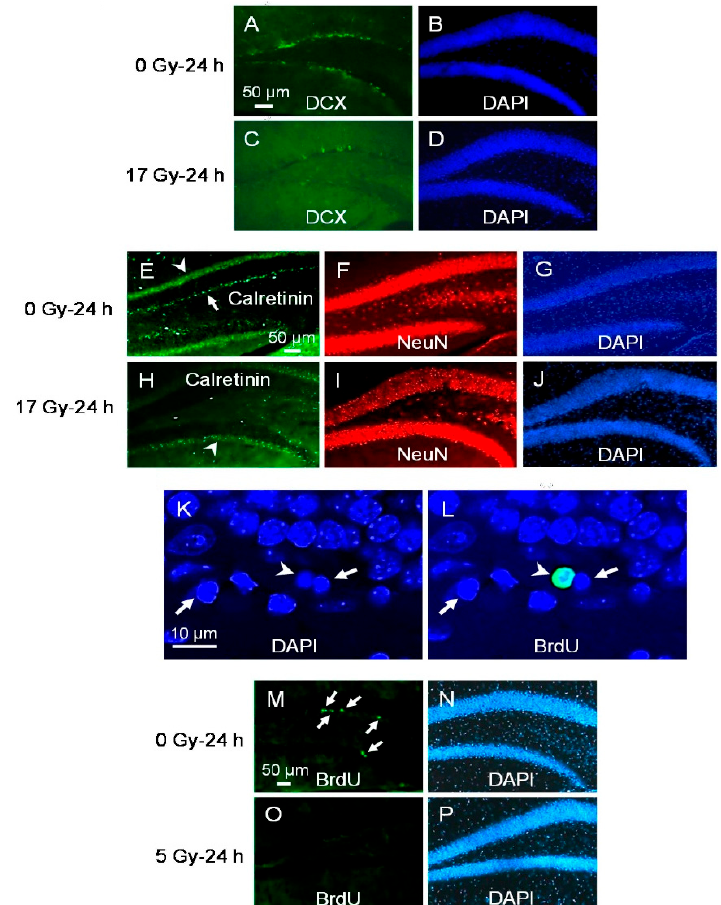
Figure 4. Loss of DCX and calretinin expressing cells, and proliferating cells in subgranular zone (SGZ) at 24 h after irradiation. There is a dramatic loss of DCX positive cells (( A – D ), DCX, green; DAPI, blue) and calretinin positive cells (( E – J ); calretinin cells, arrow, green; NeuN, red; DAPI, blue; arrowhead points to the band of dense calretinin immunoreactive nerve fibers at the inner molecular layer) at 24 h after irradiation. An apoptotic cell in the SGZ demonstrates bromodeoxyuridine (BrdU) incorporation (( K ) and ( L ), BrdU, green; DAPI, blue; arrowhead) whereas two other apoptotic cells show no BrdU immunoreactivity (arrows); BrdU-retained cells in the SGZ almost disappear completely at 24 h after irradiation (( M – P ), BrdU, arrows, green; DAPI, blue; mice irradiated immediately after BrdU given every 2 h for 4 doses). Table 1. Changes in neural progenitor and neuronal populations in mouse dentate gyrus at 24 h after irradiation.